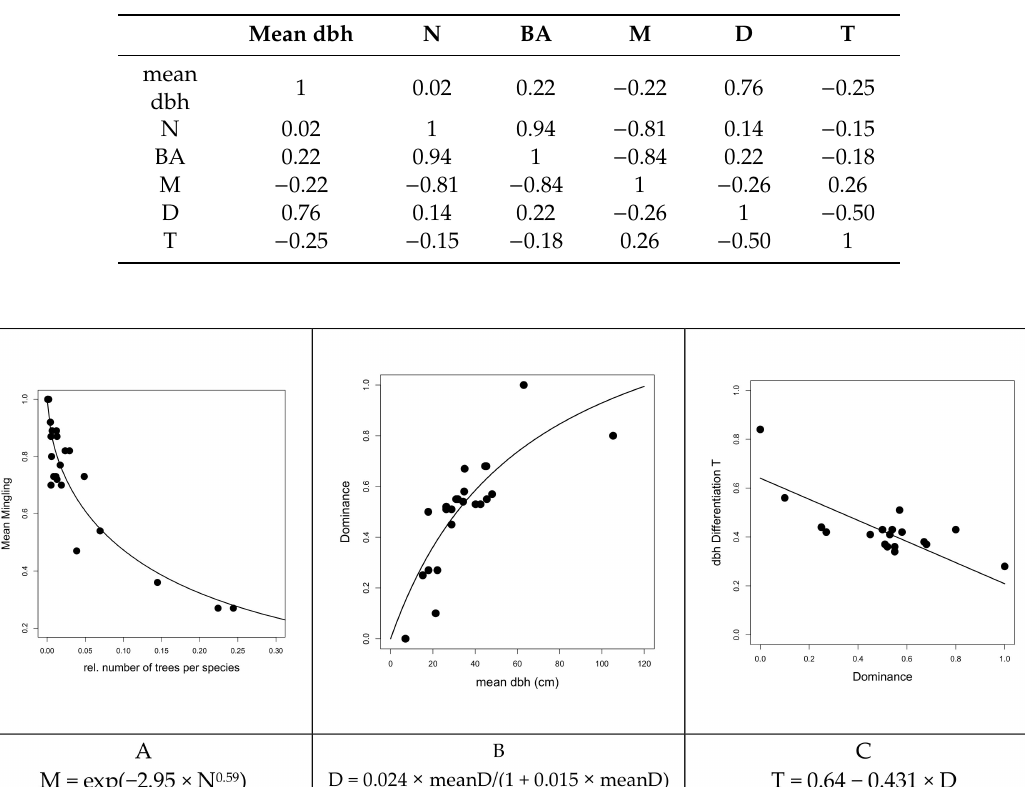
Table 5. The correlation coe ffi cients between the six variables (mean dbh, trees per ha (N), basal area (BA), structural indices mingling (M), dominance (D), and size di ff erentiation (T)) that were included in the analysis.